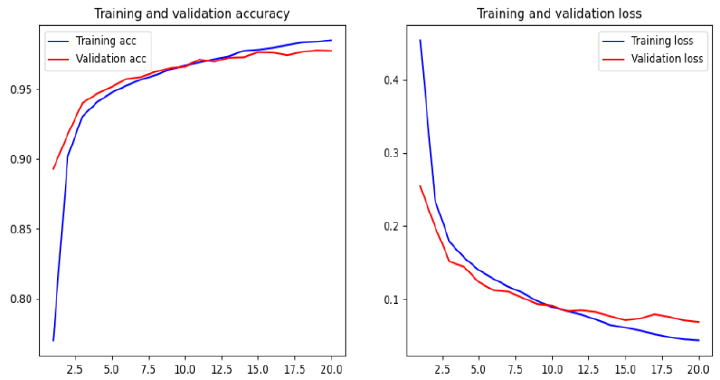
Figure 14. Evaluation of recurrent neural network (RNN) model on D2 using